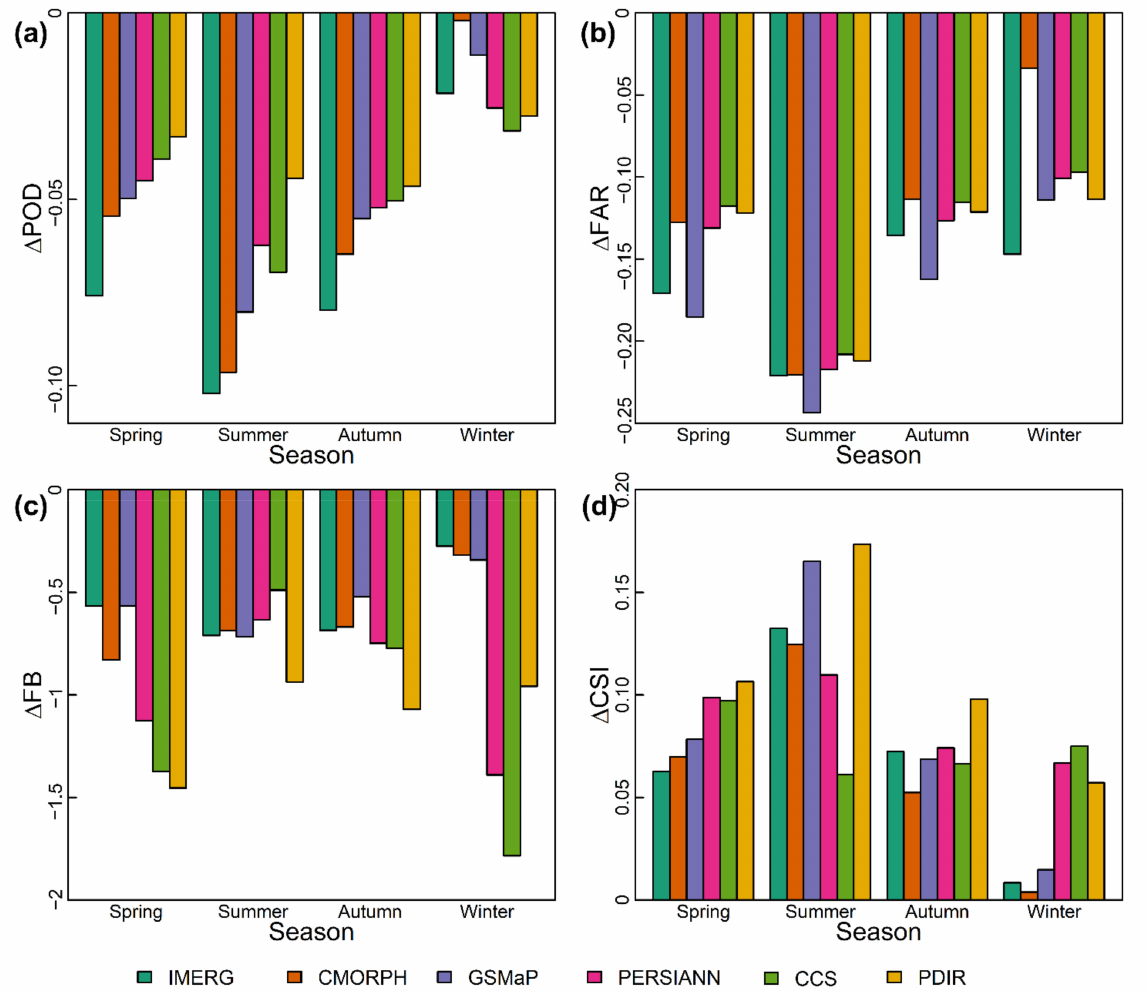
Figure 6. Seasonal variations of ( a ) ∆ POD, ( b ) ∆ FAR, ( c ) ∆ FB, and ( d ) ∆ CSI for six SPPs.